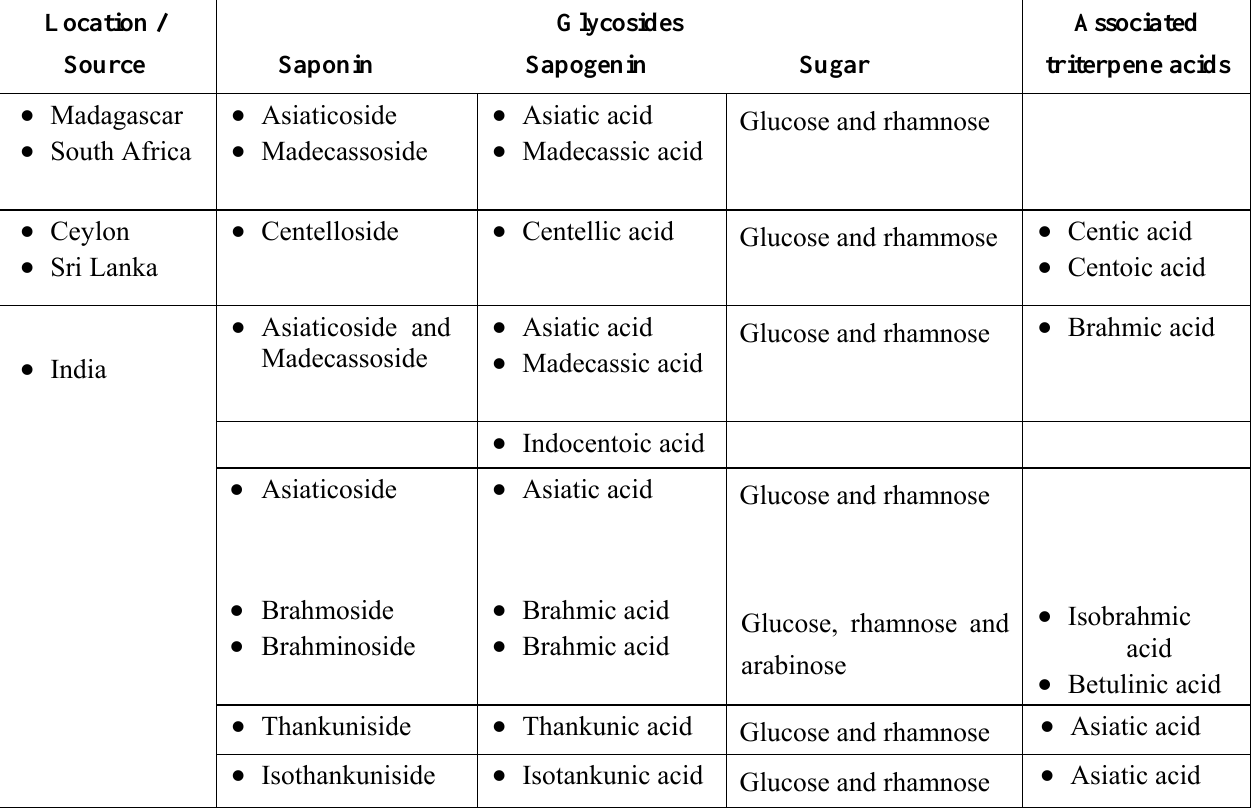
Table 4. Various saponins occur in C. asiatica due to the location and diverse environmental conditions